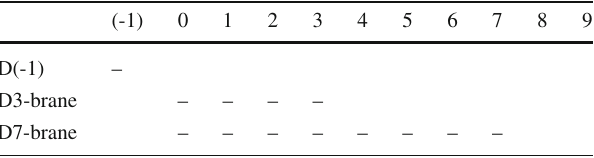
Table 1 The configuration of the D-branes in the D(-1)–D3